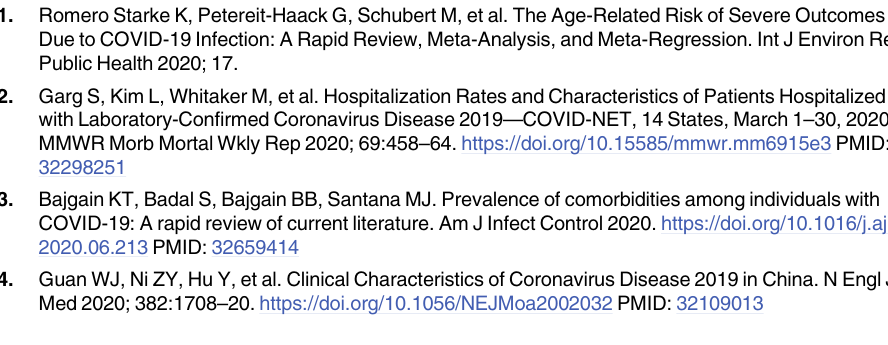
S1 Table. Clinical condition coding. S2 Table. Standardized mean differences in matched and unmatched analyses. S3 Table. Mixed effects model of ACE/ARB and COVID-19 infection including propensity score and unbalanced covariates. S4 Table. Associations with other medication classes and COVID-19